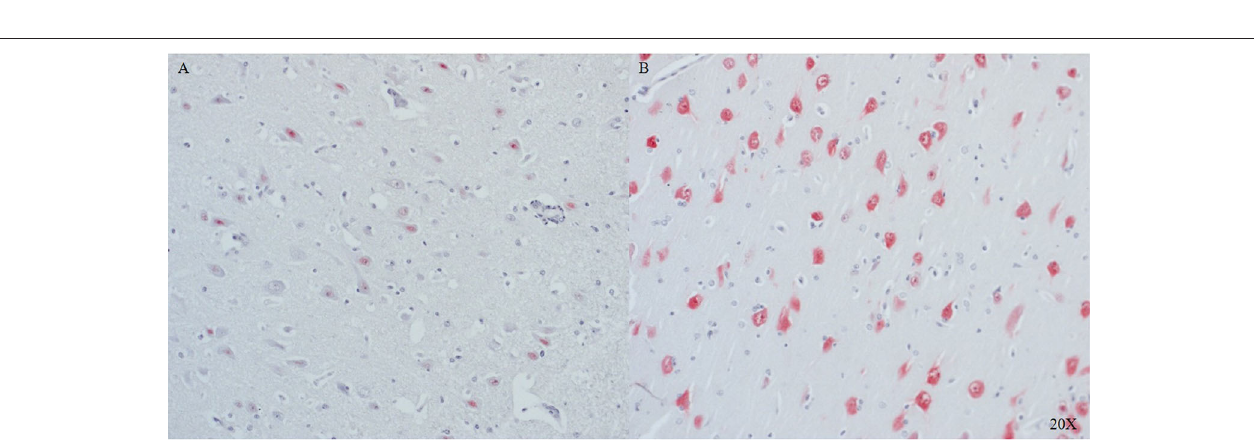
FIGURE 3 | AQP4 expression in the parietal cortex at the injury site (A) , in neighboring areas (B) and distant to the injury site (C) ( n = 6). At the injury site cellular architecture is impaired and AQP4 expression is weak (A) , moving away from the injury there is more AQP4 expression (B) , maximal AQP4 expression is present distant to the injury (C) . AQP4, aquaporin 4.